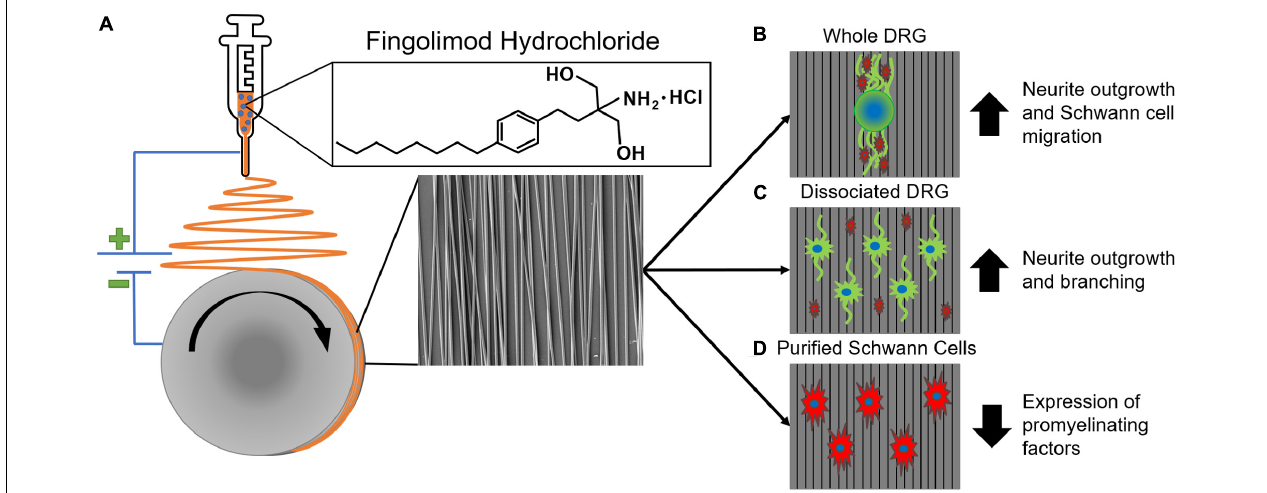
FIGURE 1 | An overview of aligned fingolimod-releasing electrospun fiber fabrication and in vitro assessment. (A) Fingolimod hydrochloride was incorporated into aligned poly(lactic-co-glycolic acid) fibers via blend electrospinning. Aligned fingolimod-releasing fibers (B) increased whole dorsal root ganglia (DRG) neurite (green) extension and Schwann cell (red) migration, (C) increased individual DRG neuron (green) neurite outgrowth in dissociated DRG cultures, and (D) decreased Schwann cell (red) expression levels of promyelinating factors in purified Schwann cell cultures.